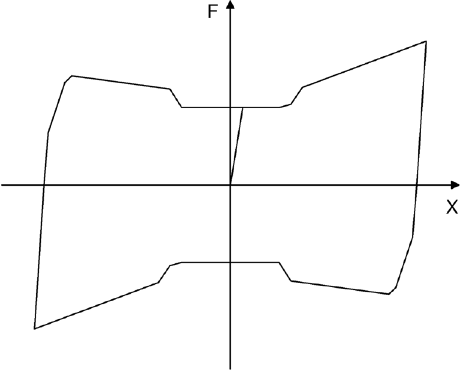
Fig. 7 Hysteresis yielded from SAP2000 analysis of SDoF model connected by super-link